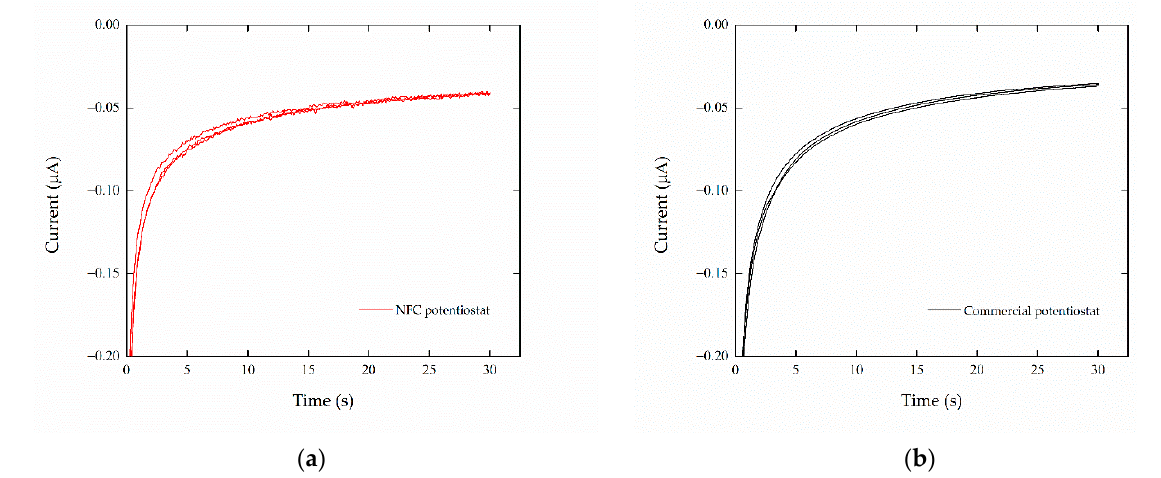
Figure 5. The chronoamperometric measurement of 25 µM ferricyanide measured with ( a ) NFC potentiostat (red) and ( b ) commercial potentiostat (black).